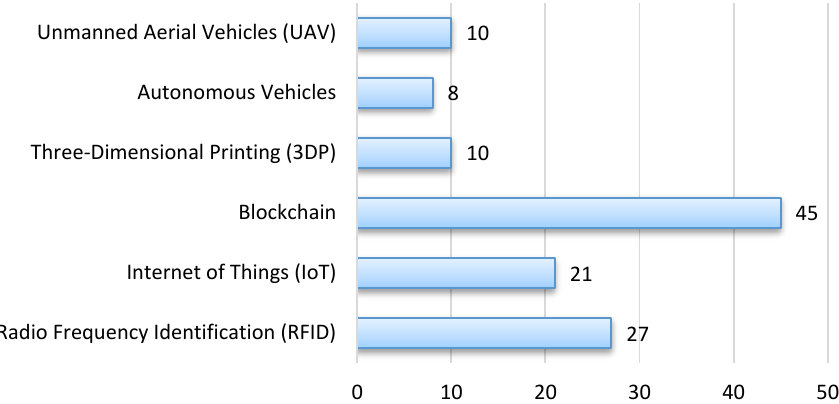
Figure 5. The number of publications related to the technologies used in different phases of the perishable food supply chain.